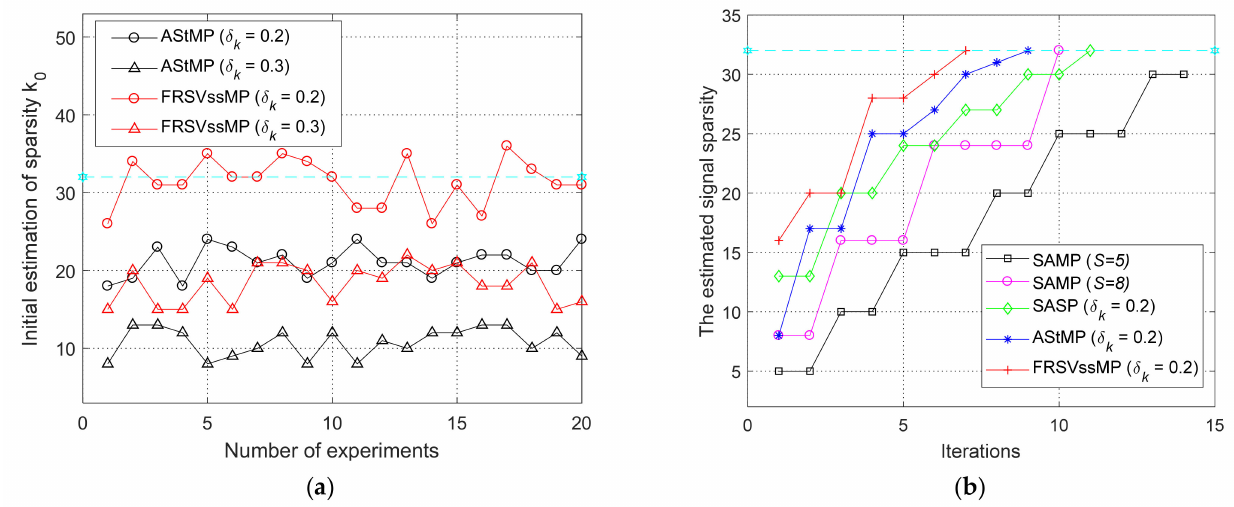
Figure 4. Performance of the initial sparsity level estimation approach. ( a ) The initial estimation of sparsity level in different experiments; ( b ) The estimated sparsity level vs.